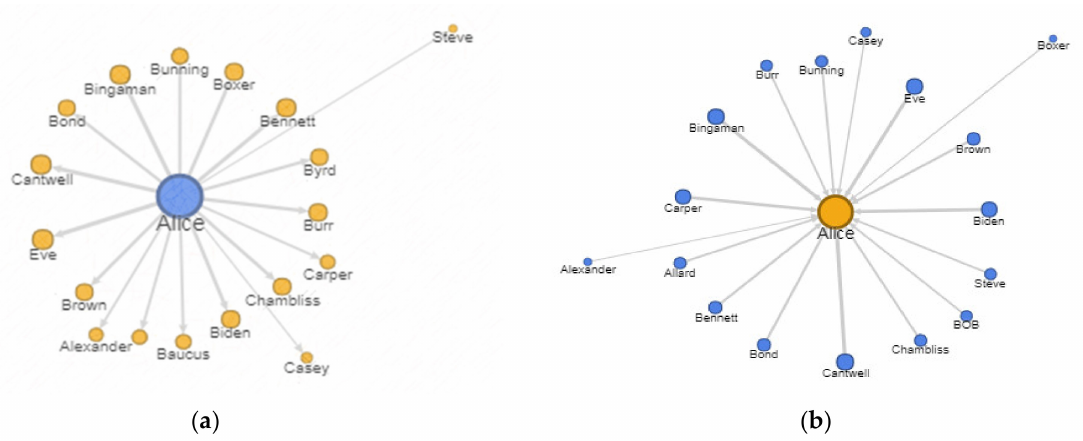
Figure 7. Interaction graph ( a ) from the subject to her contacts; ( b ) from contacts to subject. The figure shows the direction of interaction from the subject and towards the subject. The width of the lines and the distance from the center show the interaction